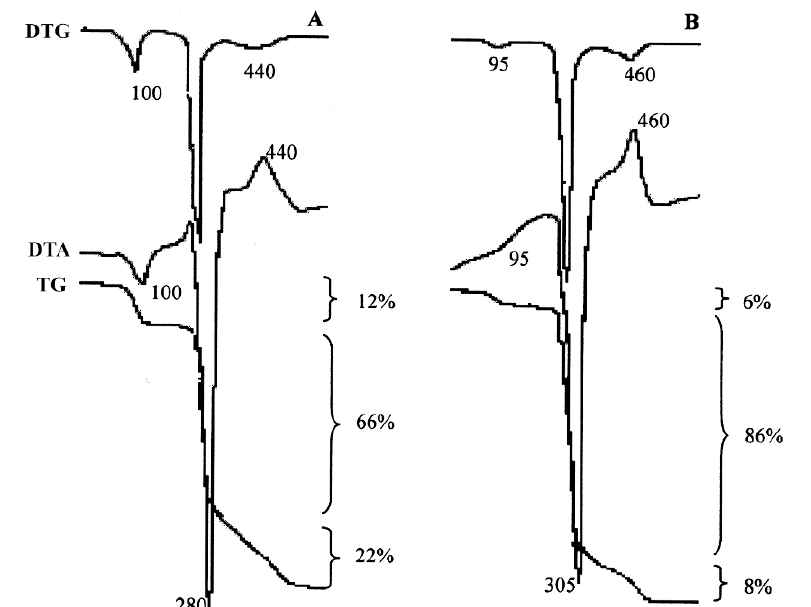
Figure 4. DTA, TG and DTG curves of β -cyclodextrin (A) and 2-hydroxypropyl- β -cyclodextrin (B).